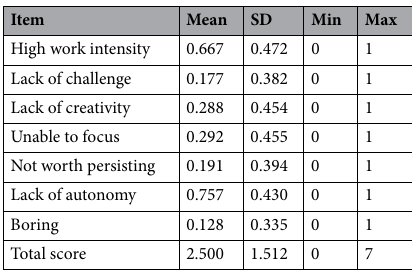
Table 2. Work alienation.